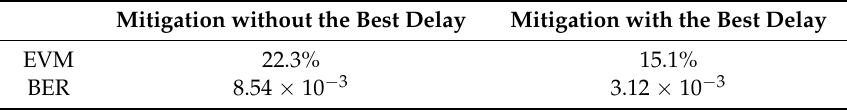
Table 1. EVM and BER of weak 16QAM after nonlinearity mitigation with or without the best